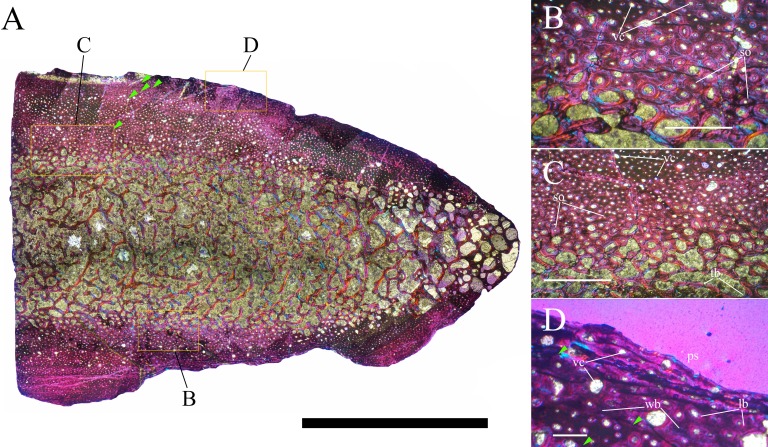
MSNVE 3714, base of the neural spine of dorsal vertebra 14, transverse thin section.Panoramic view of the cranial half of the section (A); Haversian systems in the innermost cortex (B); transition between the compacta and the medullary cortex with erosional cavities and remodeling (C); detail of the outer cortex showing absence of an EFS and outermost LAGs (D). Abbreviations: lb, lamellar bone; ps, periosteal surface; so, secondary osteons; tb, trabeculae; vc, vascular canals; wb, woven bone. Green arrows point to the LAGS. Scale bars equal 10 mm in A, 1 mm in B and C, and 500 µm in D.